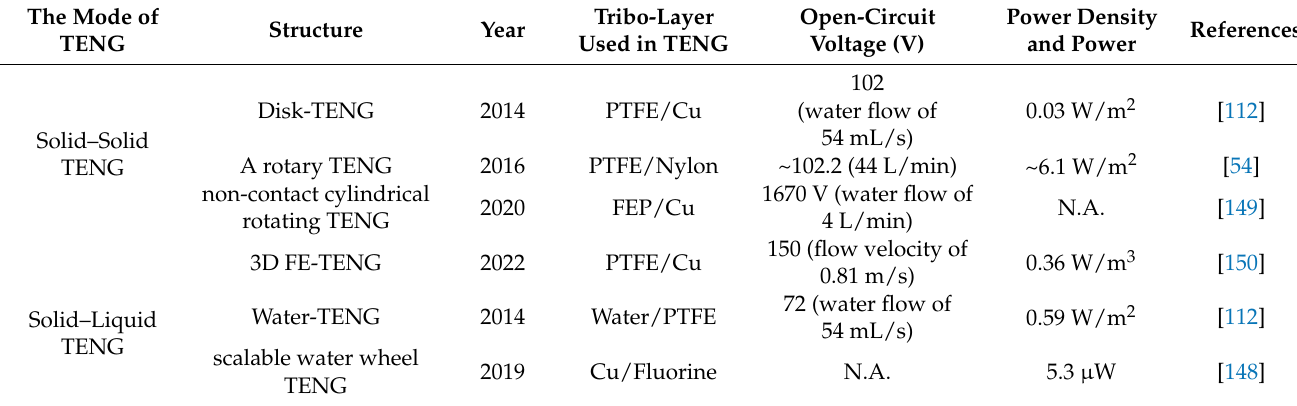
Table 2. Summary of TENGs for water flow energy